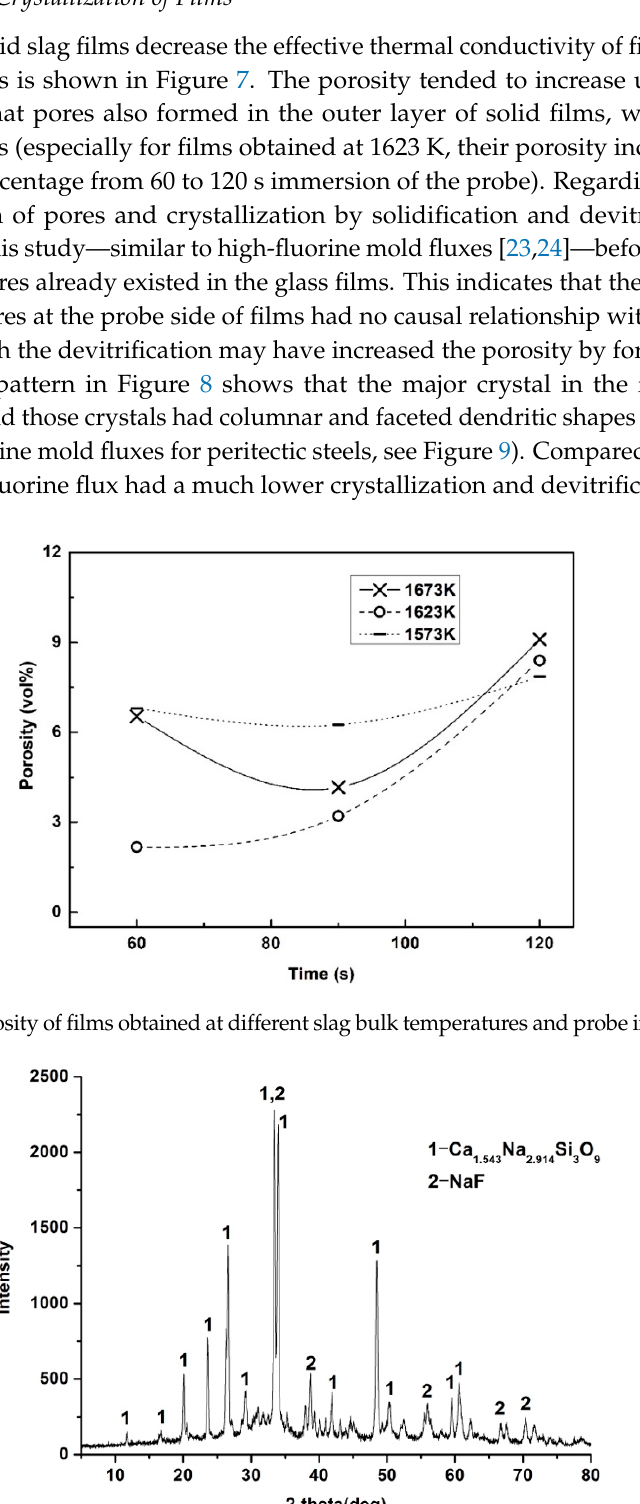
Figure 8. X-ray diffraction pattern of pulverized solid film (probe immersion time: 120 s; slag temperature: 1623 K; Cu-K α radiation).